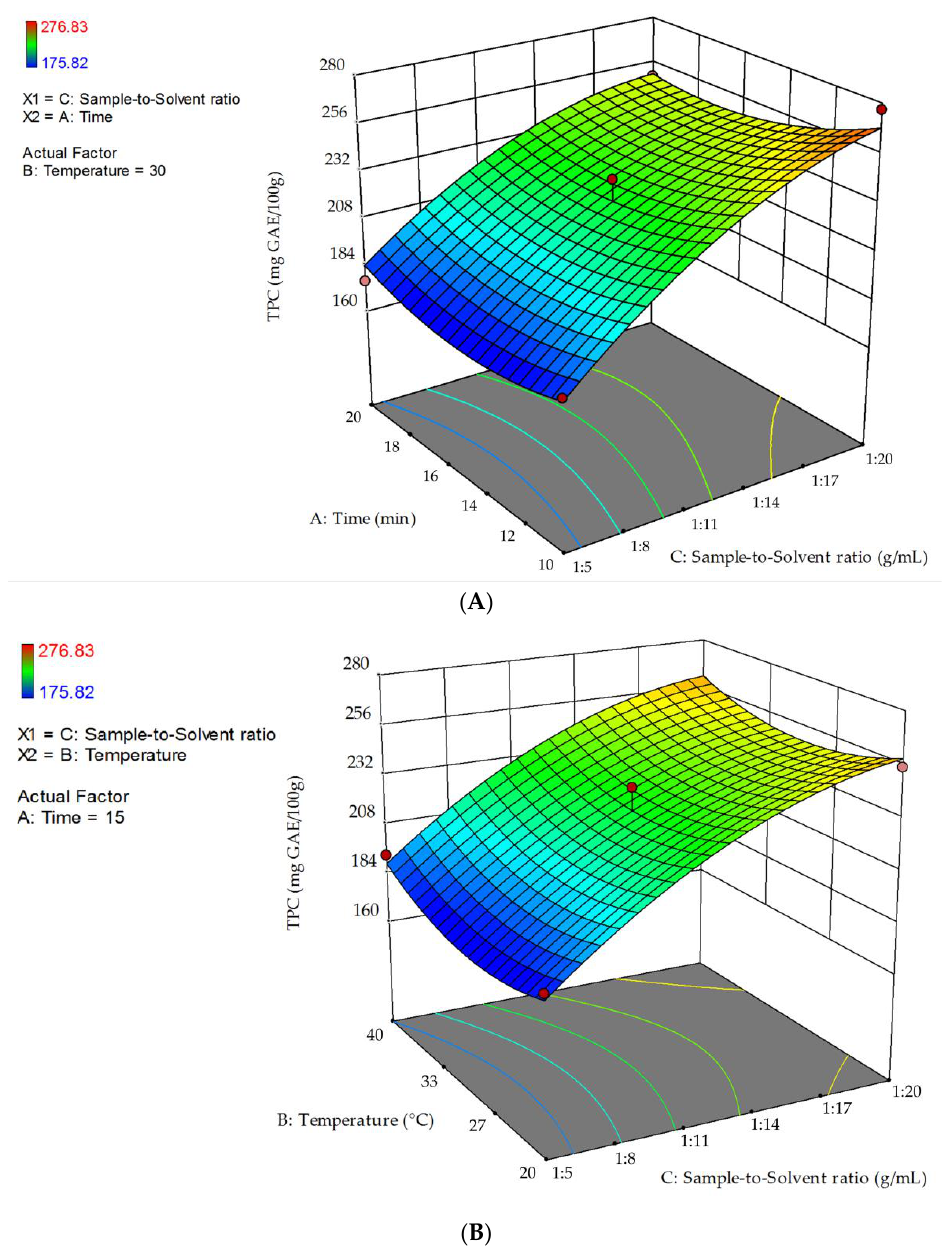
Figure 1. 3D response surfaces of TPC as a function of the interaction between the significant factor sample-to-solvent ratio and: ( A ) extraction time, and ( B ) extraction temperature. sample-to-solvent ratio and: ( A ) extraction time, and ( B ) extraction